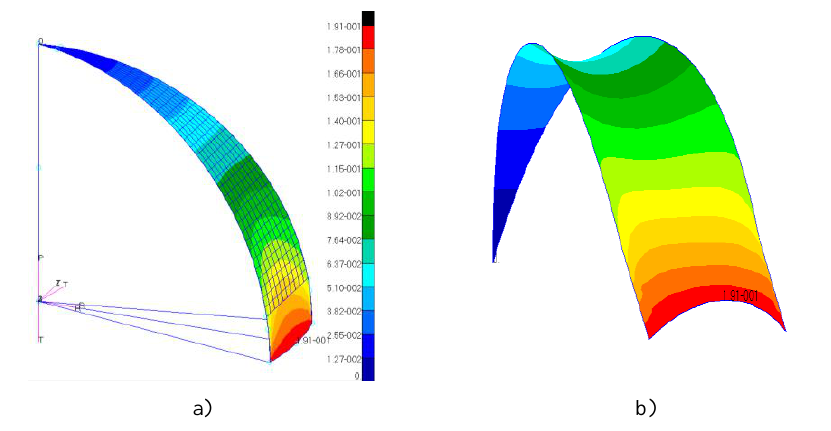
Fig. 28. Deformed state of a single lobe: a) deformed state with indication of initial state in the form of finite element mesh, b) deformed lobe on the enlarged scale.